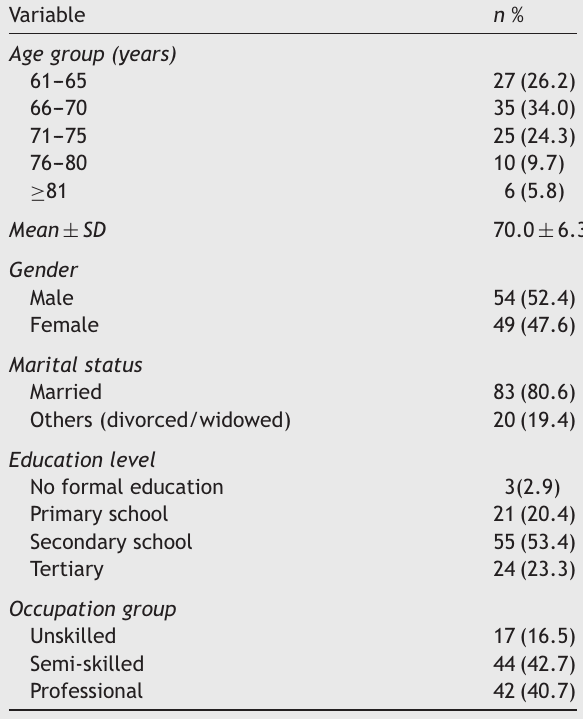
and the high (2.0, 4.0, and 8.0 kHz) frequencies was per- formed.